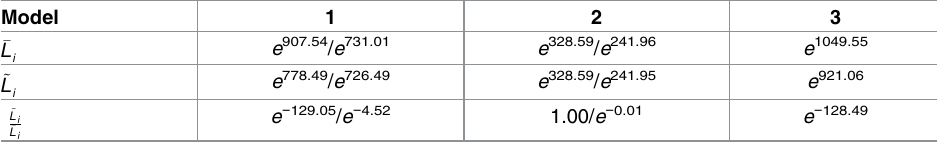
Table 10. Likelihood values for comparing static and dynamic models.